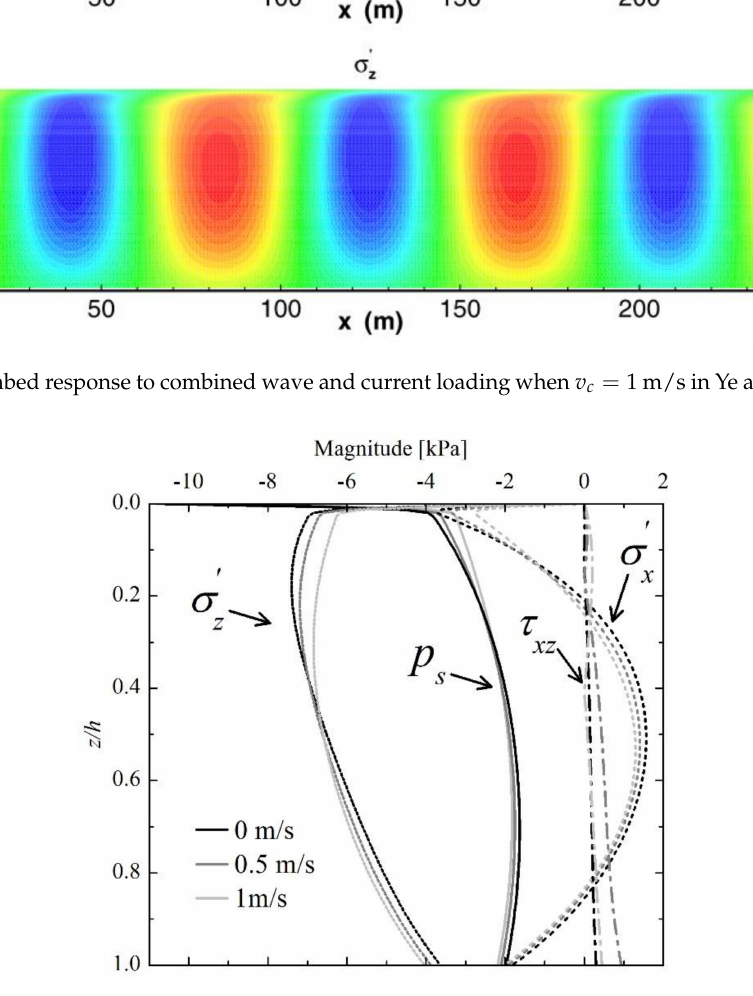
Figure 7. Vertical distributions of minimum wave-induced pore pressure with various current